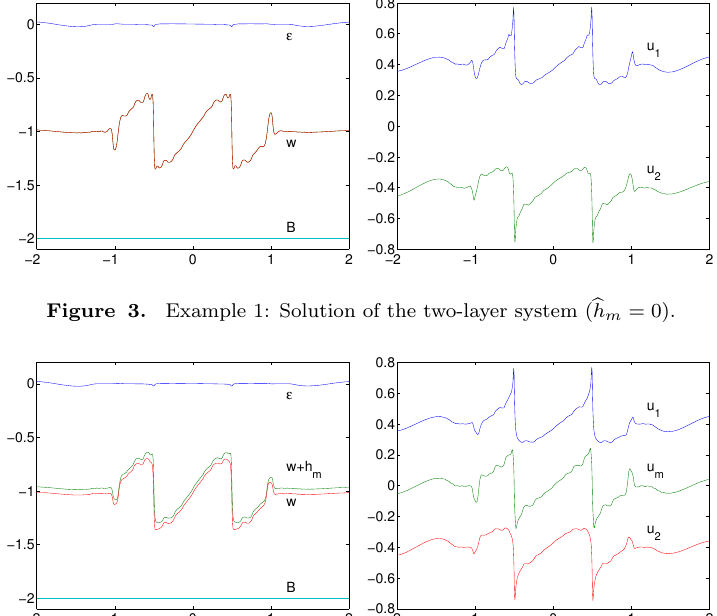
−2 −1 Figure 4. Example 1: Solution of the three-layer system with (cid:98) h m = 0 . 05.